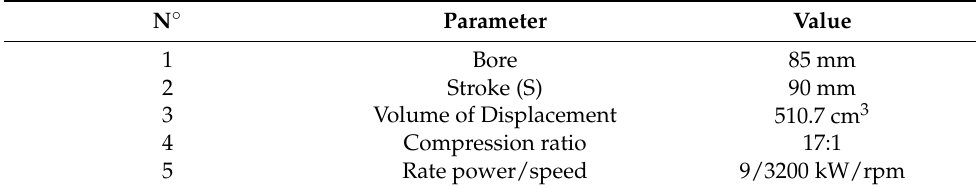
Table 1. Specifications of the engine.